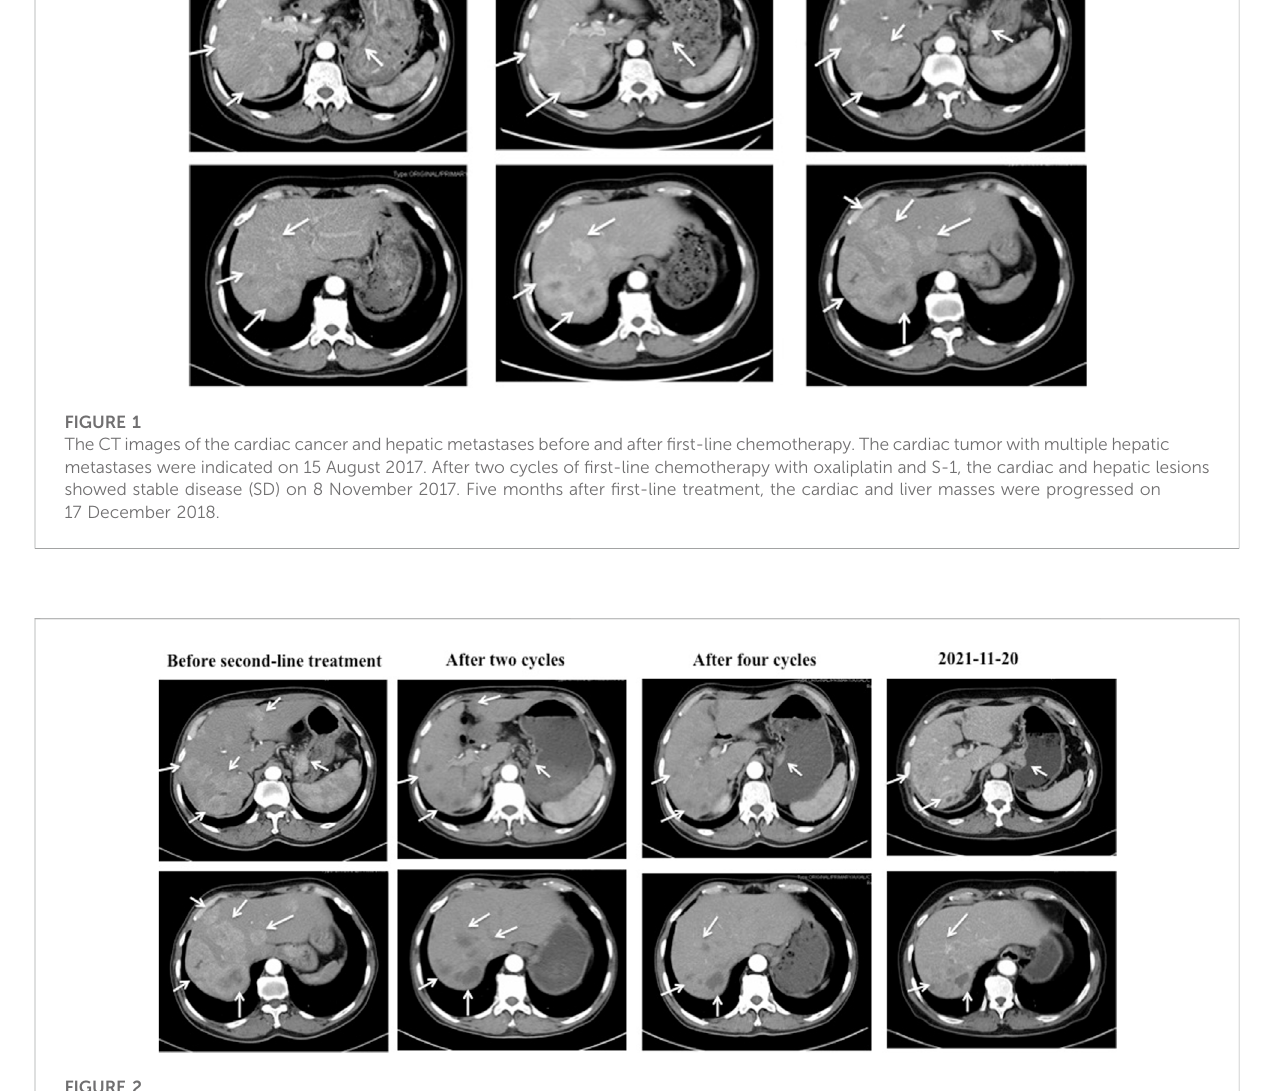
FIGURE 2 The CT images of the cardiac cancer and hepatic metastases during second-line treatment with apatinib and paclitaxel. Before second-line treatment, theCT showed markedly enlarged cardiac tumor and multiple hepatic metastases with abundant blood supply. The average CT ratio (the density of the liver metastases/the density of abdominal aorta) during arterial phase on CT imaging was 79/210. After two cycles of second-line therapy, the cardiac tumor and hepatic metastases showed a response of partial response (PR), and the ratio was 38/281 with an obviously decreasingofthedegreeofenhancement.Fourcycleslater,theef fi cacyremainedPR.TherecentCTexaminationwason20November2021,which showed the disease remained an ef fi cacy of